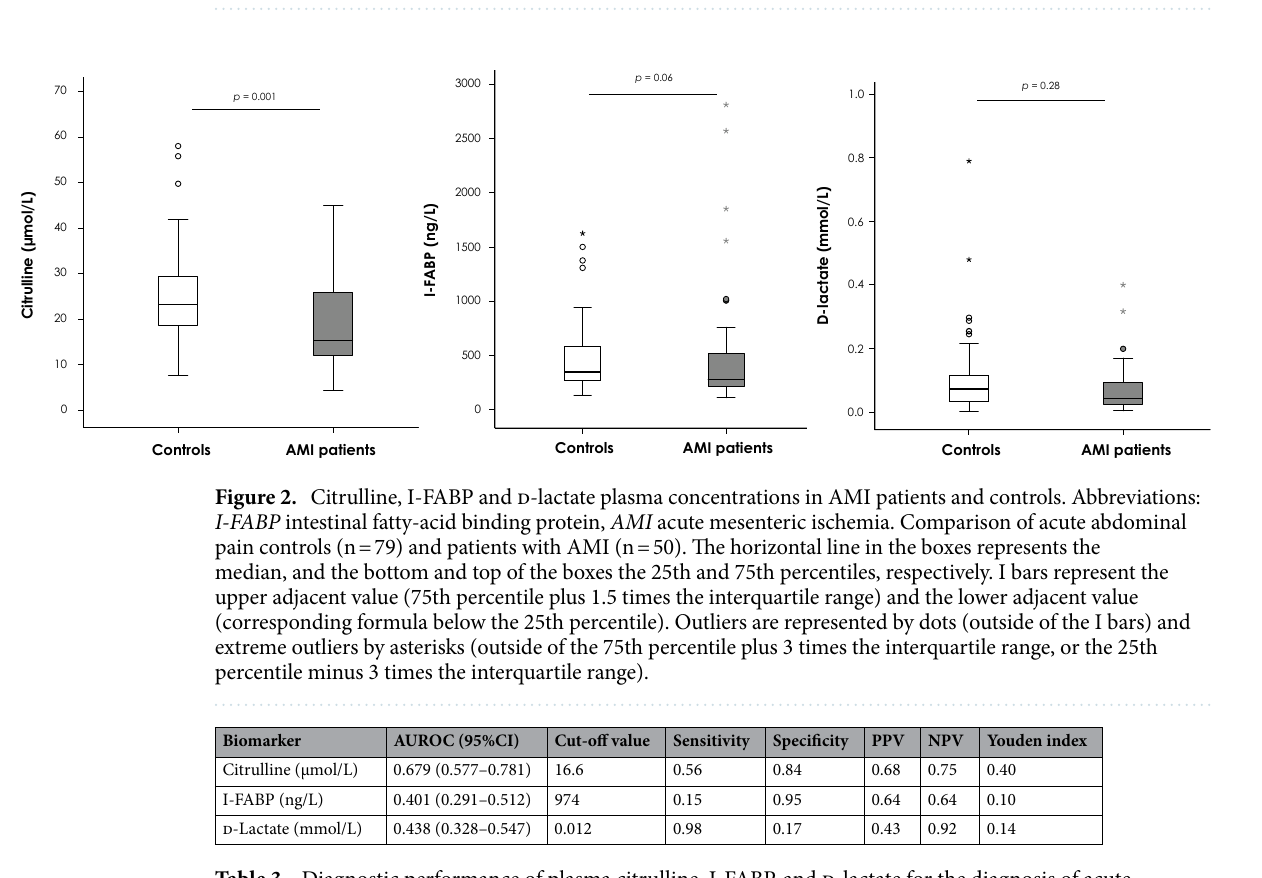
Table 3. Diagnostic performance of plasma citrulline, I-FABP, and d-lactate for the diagnosis of acute mesenteric ischemia. PPV and NPV were calculated based on a prevalence of AMI = 0.39 in the